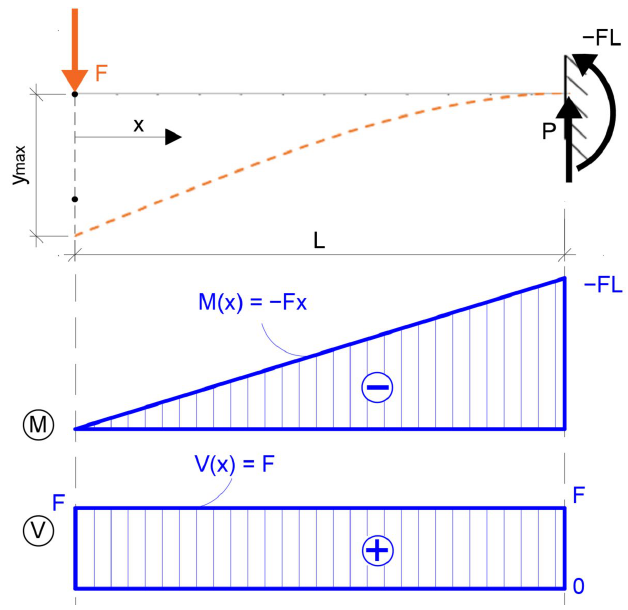
Figure 2. Cantilever beam and its internal forces from single concentrated